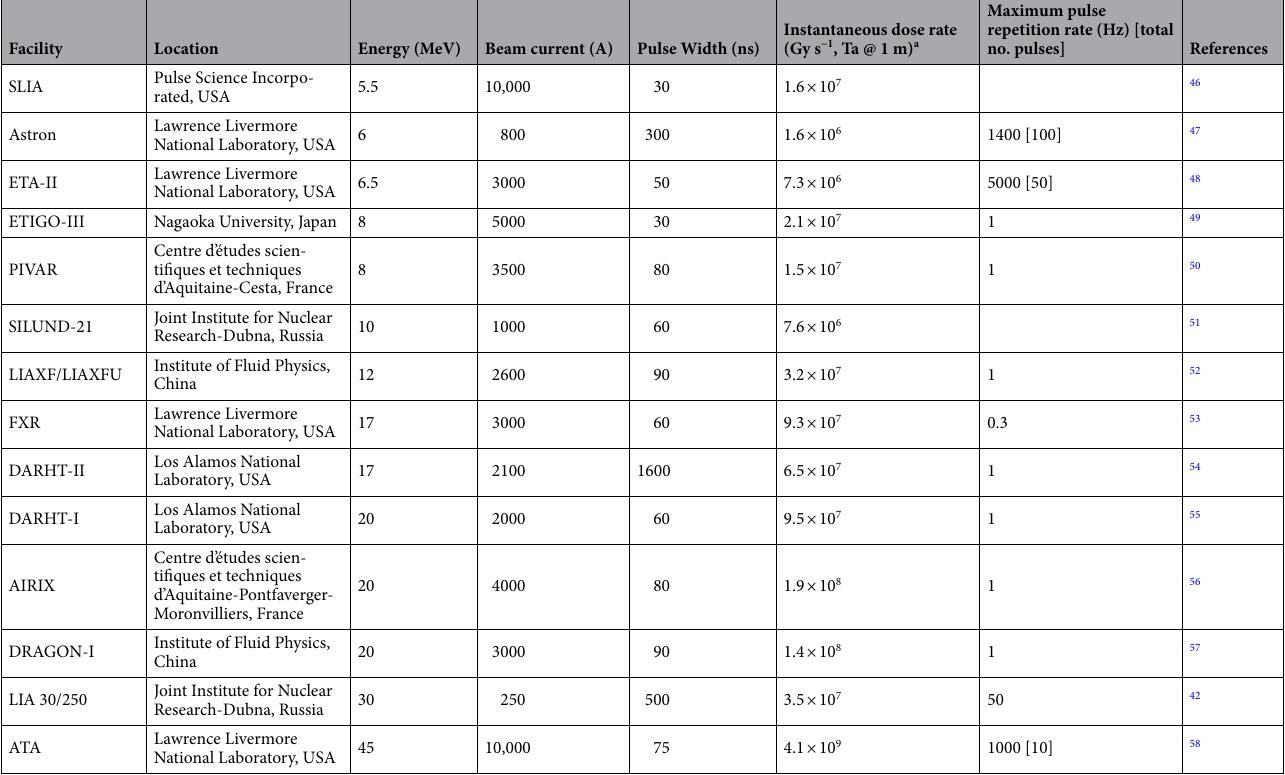
˙ D 2.65 = 1.7 × 10 4 I Beam Energy